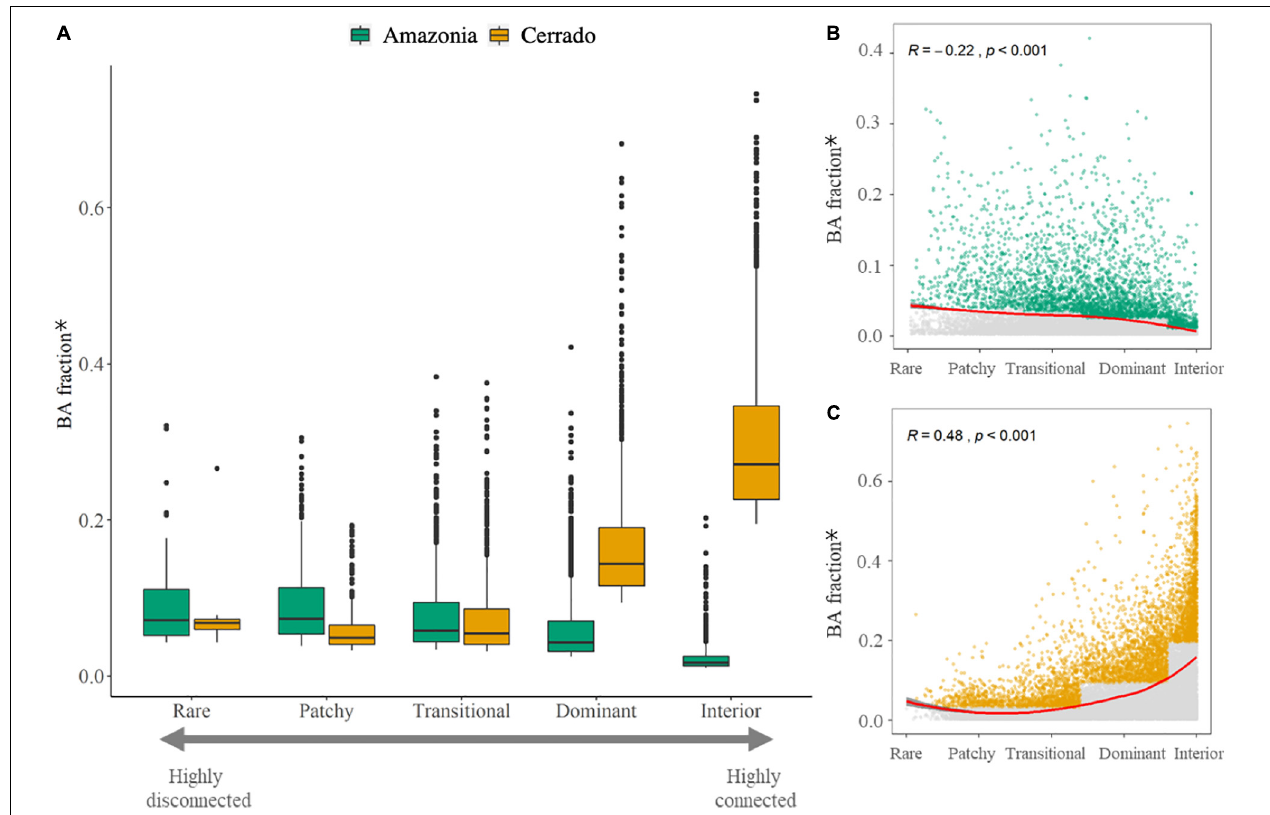
FIGURE 3 | (A) Boxplot with the average (2002–2018) normalized burned area (BA) fraction* by each FAD category for Amazonia and Cerrado biomes; (B) Scatterplot showing the relationship between the normalized BA fraction and FAD for Amazonia, points highlighted in green were used in the boxplot ( > 75th percentile) for each category, gray points are the lower 75th percentile and the red line shows the fitted loess regression considering all the grid-cells; (C) Scatterplot showing the relationship between the normalized BA fraction and FAD for Cerrado, points highlighted in orange were used in the boxplot ( > 75th percentile) for each category, gray points are values < 75th percentile and the red line shows the fitted LOESS regression considering all the grid-cells. The average and standard deviation maps used to elaborate the scatterplots can be found in Supplementary Figures 1, 2 for Amazonia and Cerrado, respectively. * Normalized BA fraction = Total BA inside natural fragments / Total area of the